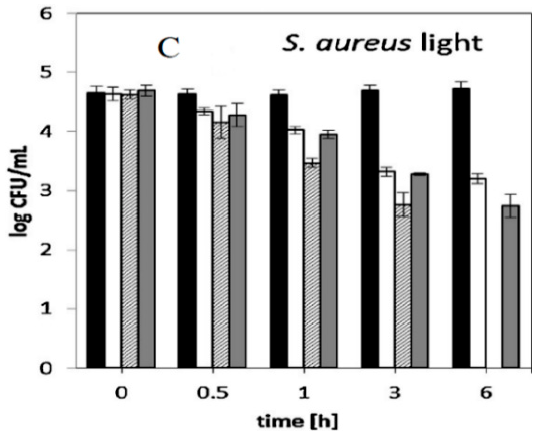
Figure 41. Log reduction of E. coli treated with undoped ZnO SG, ZnO:TFA 1:1 and ZnO:TFA 1:2 under ( A ) the dark and ( B ) visible light conditions. ( C ) Bactericidal activity of those samples against S. aureus under visible light. All tests were conducted in triplicates. Reproduced from [310] with permission of Elsevier.